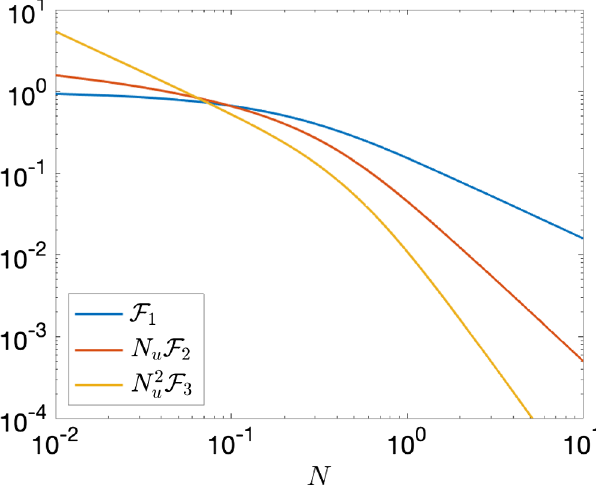
F ð N Þ in Eq. (32). K ≫ 1 is h